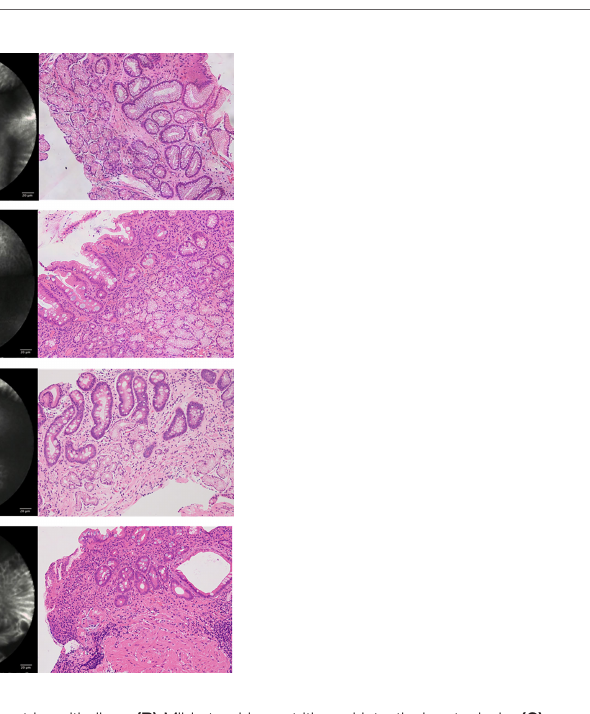
FIGURE 1 | Confocal imaging and histopathology of gastric epithelium. (A) Normal gastric epithelium. (B) Mild atrophic gastritis and intestinal metaplasia. (C) Moderate atrophic gastritis and intestinal metaplasia. (D) Severe atrophic gastritis and intestinal